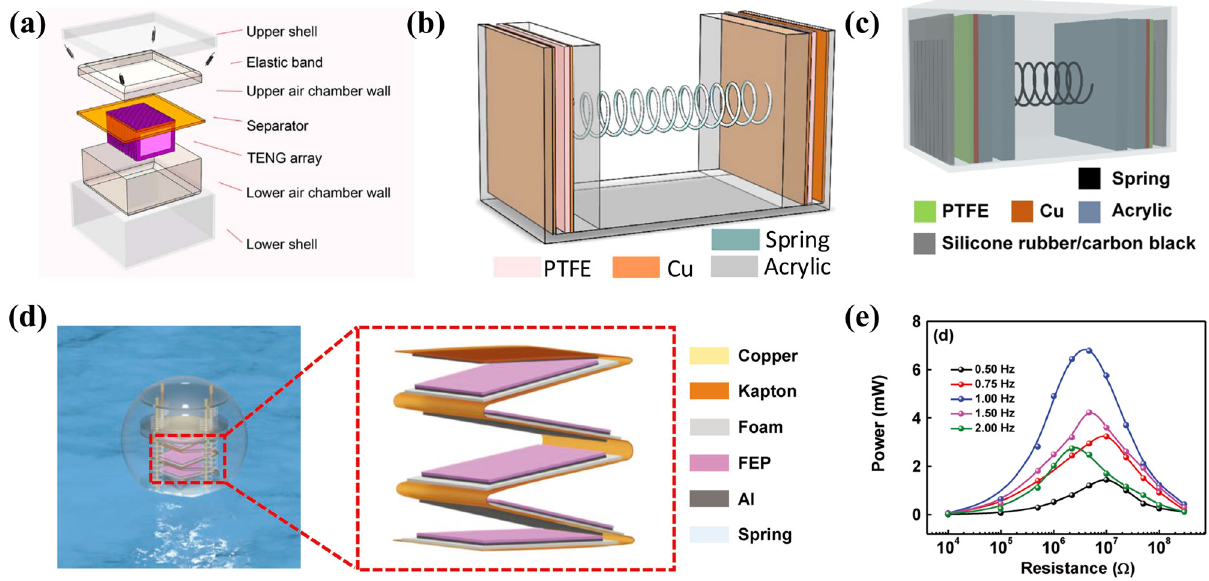
Figure 6: ( a ) Schematic of the integrated TENG array device based on air - driven membrane structure [ 62 ] , ( b ) schematic of spring - assisted TENG structure [ 63 ] , ( c ) schematic diagram of a silicon - based spring - assisted TENG device [ 64 ] , ( d ) schematic diagram of spring - assisted multilayer TENG structure, and ( e ) output power – resistance curves of fi ve - element spherical TENG at di ff erent water wave frequencies [ 65 ]